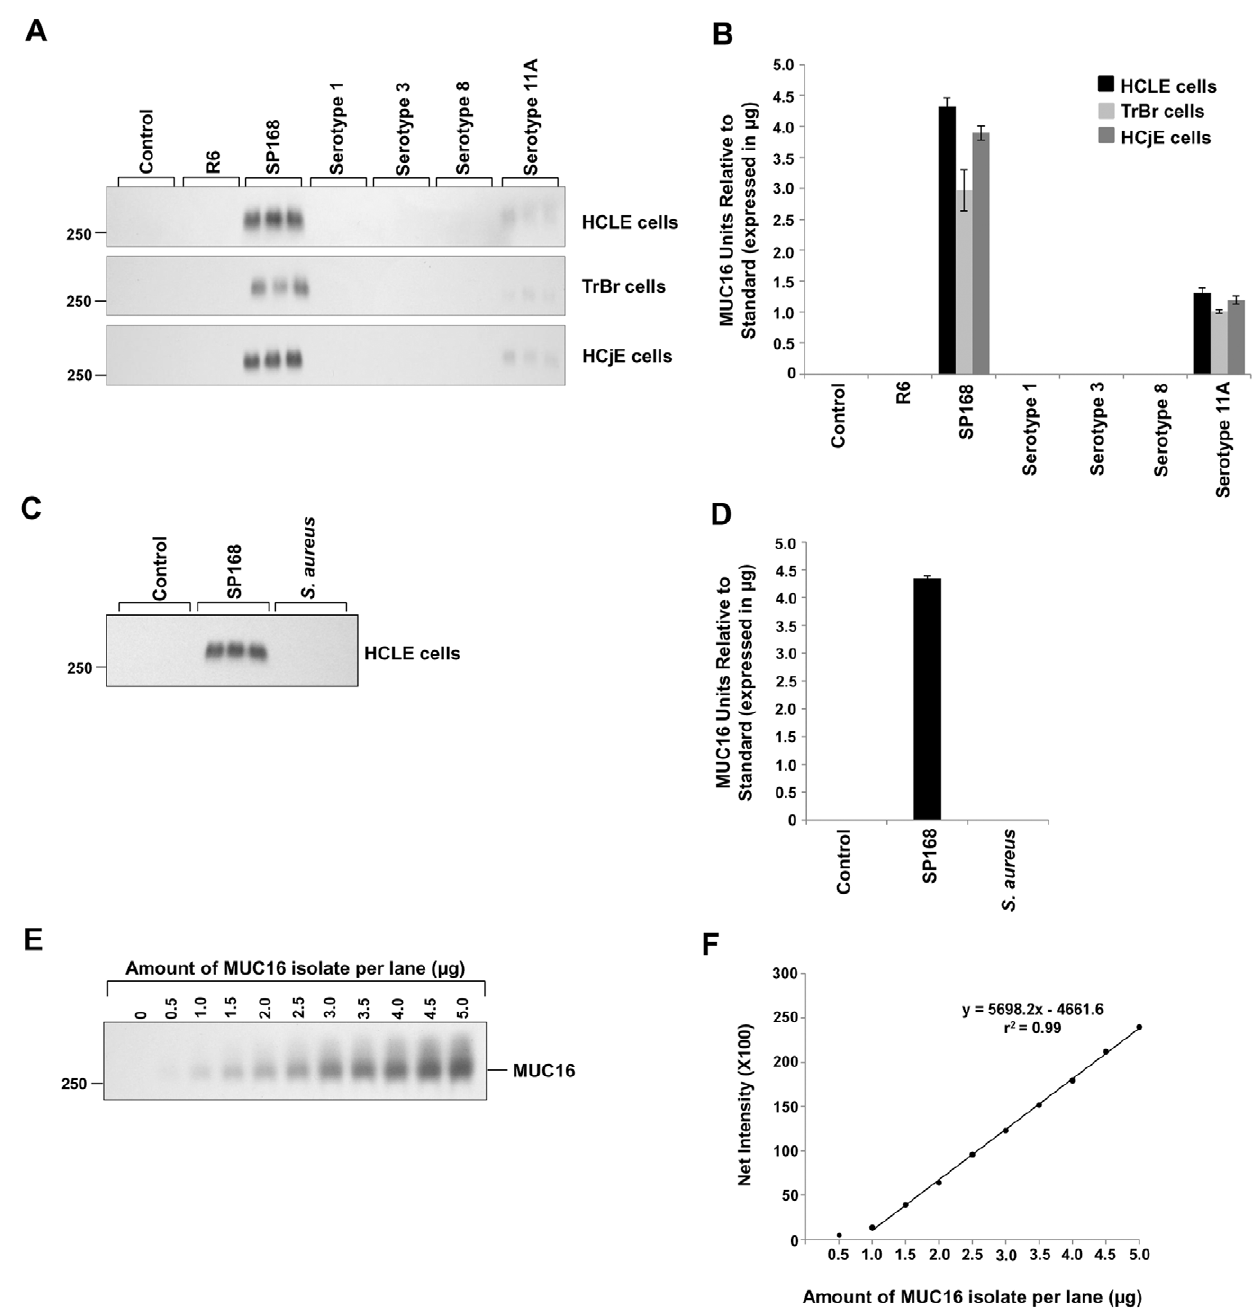
Figure 1. Epithelial MUC16 release by growth culture filtrates from different S.pneumoniae species and S.aureus . A ) Western blots using M11, a MUC16 ectodomain-specific antibody, on culture supernatants of HCLE, TrBr, and HCjE cells after exposure to growth culture filtrates from S. pneumoniae strains R6 and SP168, and serotypes 1, 3, 8, and 11A. The 250 kDa standard marker is indicated on the left. B ) Quantitative analyses of the western blots in (A) demonstrated that bacterial culture filtrates from only SP168 and serotype 11A induced release of the MUC16 ectodomain (n=3). C ) Western blot with the M11 antibody, on culture supernatants of HCLE cells after exposure to growth culture filtrates from S. pneumoniae strain SP168 and S. aureus ALC1435. D ) Quantitative analysis of the western blot in (C) shows the inability of growth culture filtrate derived from S. aureus to induce MUC16 ectodomain shedding (n=3). Data represent MUC16 units relative to the standard 6 standard error of the mean (SEM). E ) Western blot using the M11 antibody on known, increasing amounts of a partially purified MUC16 isolate. F ) A standard curve that was generated by plotting band intensities that were in the linear range (E) vs known amounts of partially purified MUC16 protein. doi:10.1371/journal.pone.0032418.g001 indicated ZmpC as the MUC16 sheddase. Further evidence that treatment with wild type SP168, epithelial cultures treated with the ZmpC is indeed the MUC16 sheddase came from the finding that growth culture filtrate obtained from the zmpC D mutant resulted in only those S. pneumoniae serotypes containing the zmpC gene no MUC16 ectodomain release (Figure 5 A, B). These results induced MUC16 ectodomain shedding (Figures 1A and 6). confirm findings from mass spectrometric analysis, which